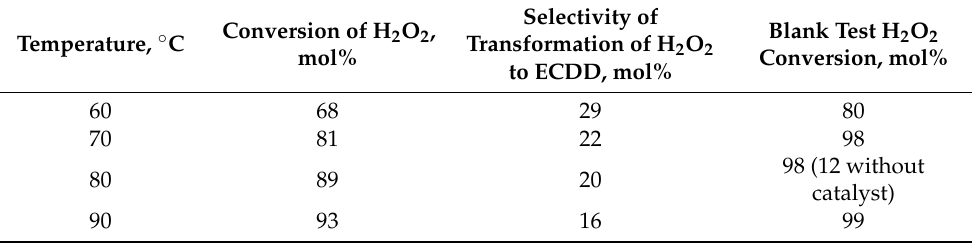
Figure 11. Conversion of CDT and selectivity of transformation of CDT to ECDD as a function of time for reactions performed at different temperatures. Reaction conditions: i-PrOH solvent, 80 wt%; catalyst, 5 wt%; CDT:H 2 O 2 molar ratio, 1:1; mixing speed, 500 rpm. Table 1. Values of the conversion of H 2 O 2 and selectivity of transformation of H 2 O 2 to ECDD obtained after 4 h of performing the reaction at different temperatures. The reaction conditions were as described in Figure 11. Selectivity of Conversion of H 2 O 2 , Blank Test H 2 O Temperature, ◦ C Transformation of H 2 O 2 mol% to ECDD, mol%